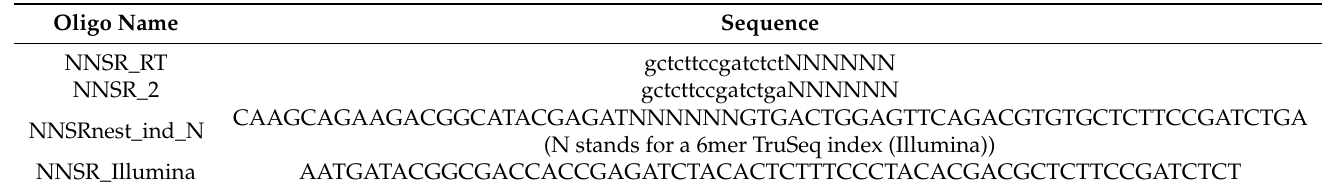
Table 1. Primers used for cDNA